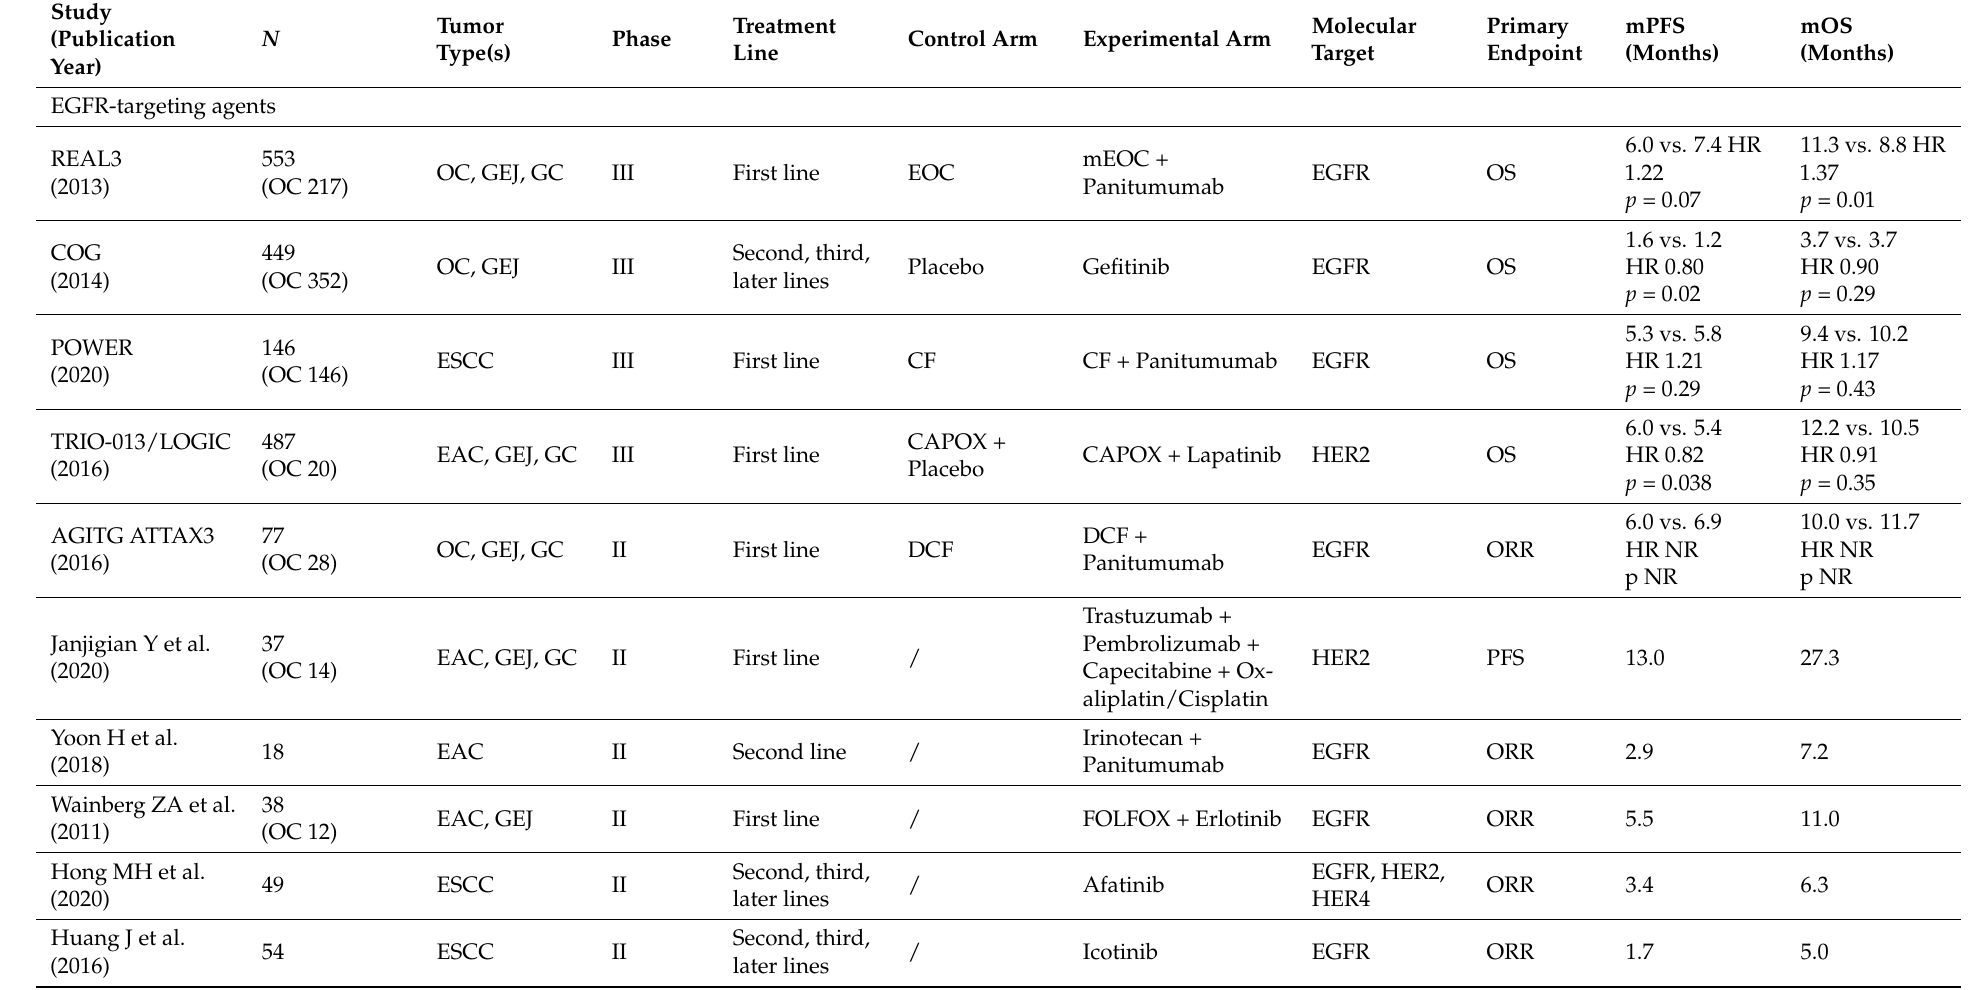
Table 2. Targeted therapies trials in metastatic oesophageal